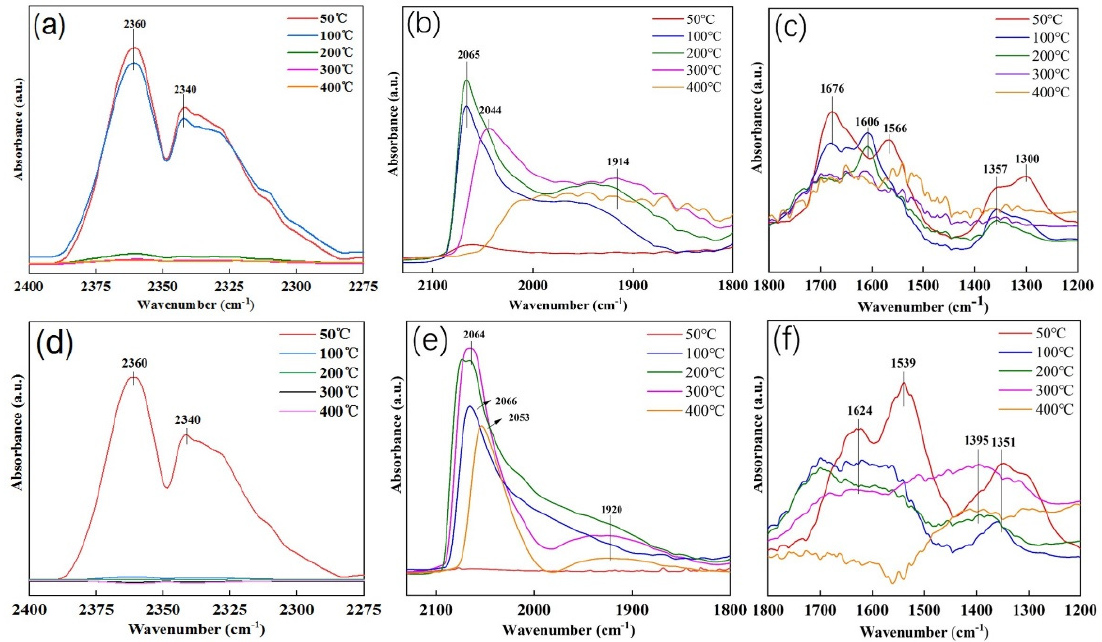
Figure 5. In-situ DRIFT spectra of species on catalyst pre-adsorbed by CO 2 and then purged by H 2 : Pt/SrTiO 3 catalyst ( a – c ) and Pt/SrTiO 3 -L catalyst ( d – f ).